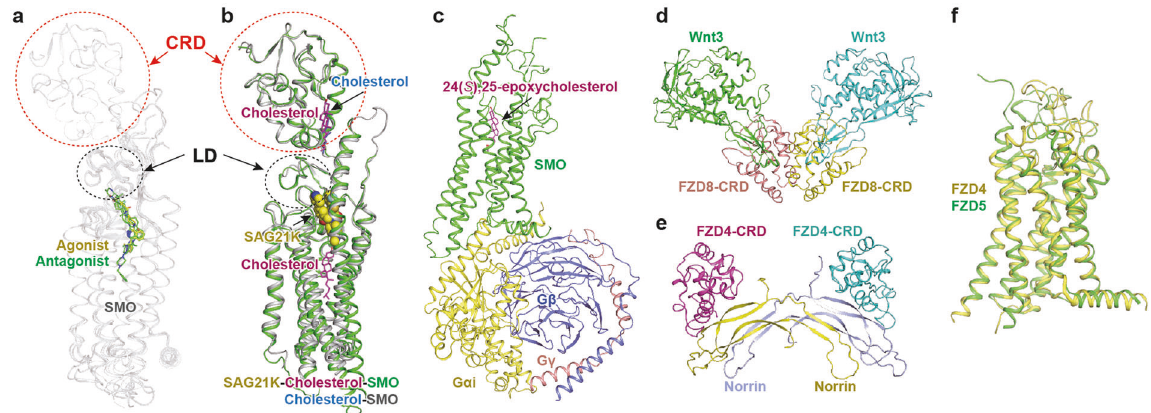
Fig. 8 Structural feature of class F GPCRs. a Superposition of SMO crystal structures bound to agonists (yellow sticks) and antagonists (green sticks). The following structures are shown (PDB codes): 4JKV, 4N4W, 4O9R, 4QIM, and 5V56. CRD and LD (linker domain) are highlighted; b A comparison of structures of full-length SMO in the active state (PDB codes: 5L7D and 6O3C). Cholesterols are indicated. SAG21K, the agonist of SMO, is shown as yellow spheres. c The cryo-EM structure of SMO TMD in complex with G i heterotrimer (PDB code: 6OT0). The agonist 24 (S),25-epoxycholesterol is shown as magenta sticks. d Crystal structures of the Wnt3-FZD8 CRD complex. e Crystal structures of the Norrin- FZD4 CRD complex. f A comparison of the apo TMD structures of FZD4 (PDB code: 6BD4, yellow) and FZD5 (PDB code: 6WW2,